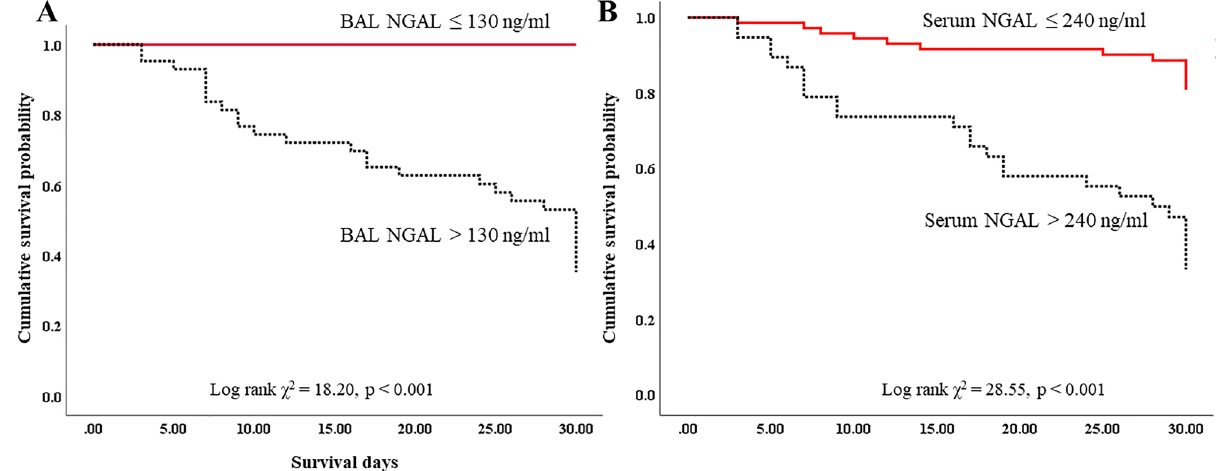
Figure 5. Kaplan Meier analysis for intensive care unit mortality. Patients with higher baseline BAL ( A ) or serum NGAL levels ( B ) showed a high mortality. BAL bronchoalveolar lavage, NGAL Neutrophil gelatinase- associated